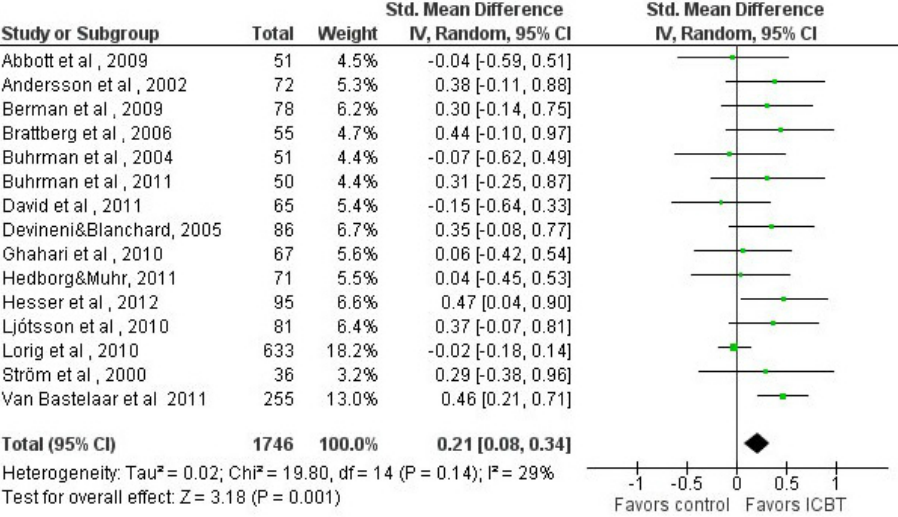
Figure 4. Forest plot of standardized mean differences of the effect on depression of Internet-based cognitive behavioral therapy compared with a passive control